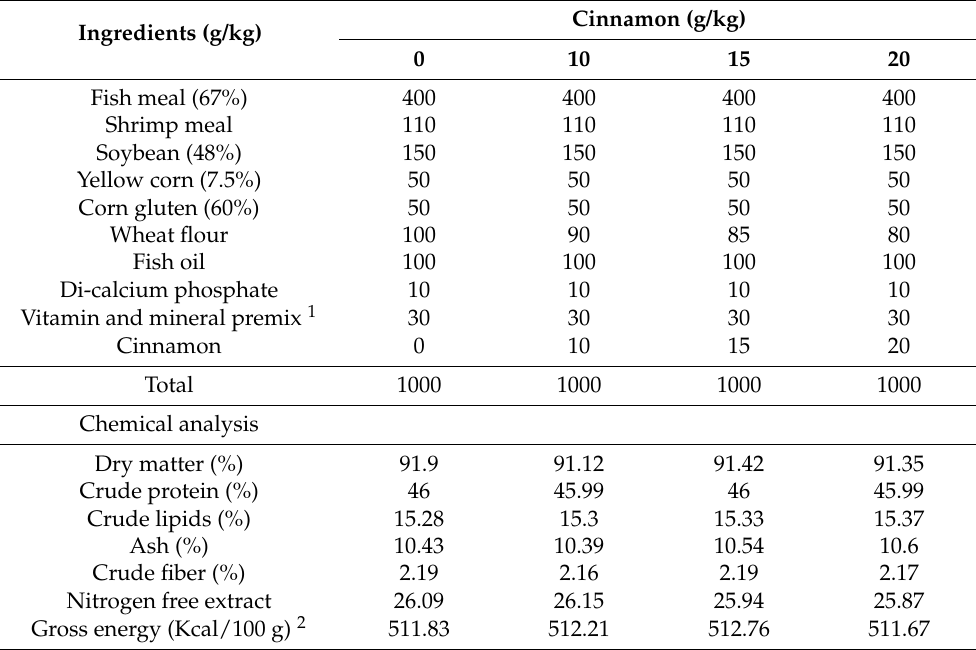
Table 1. Formulation and chemical composition of the basal